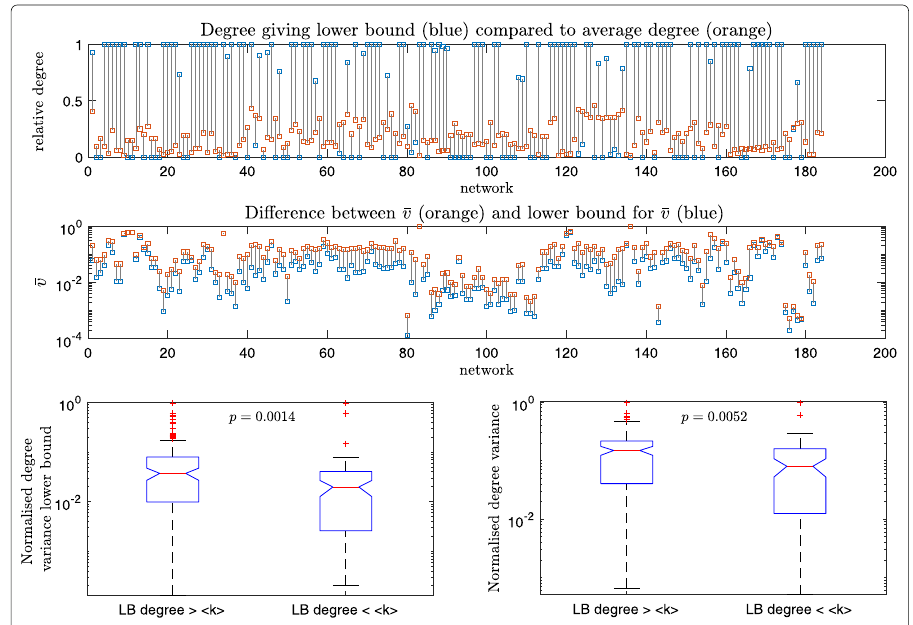
Fig. 6 Analysis of the lower bounds for 184 real world networks. The p -values in the box plots come from Wilcoxon rank sum tests. Networks whose lower bound was achieved at a degree larger than the average degree are compared against networks whose lower bounds are at degrees lower than the average. These are recorded for the lower bounds for normalised degree variance (left) and normalised degree variance (right). LB degree is the degree at which the lower bound is achieved in the network and < k > is the average degree of the